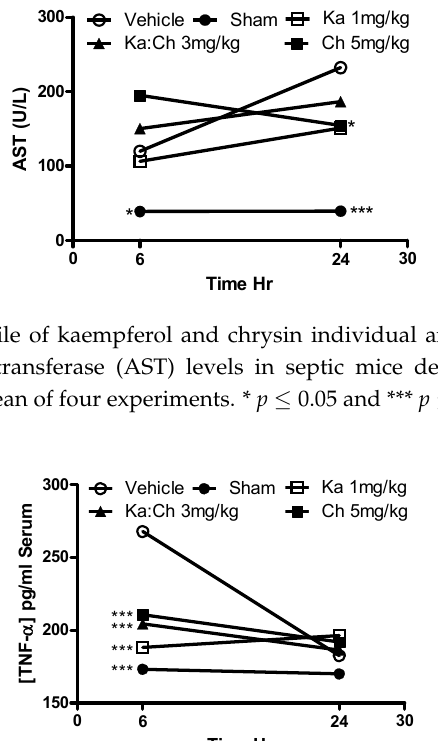
Figure 8. Time course profile of kaempferol and chrysin individual and combination treatments on serum tumor necrosis factor-alpha (TNF- α ) levels in septic mice determined using ELISA kit. Each point represents the mean of four experiments. *** p ≤ 0.001 versus CLP/vehicle (Student’s t -test).